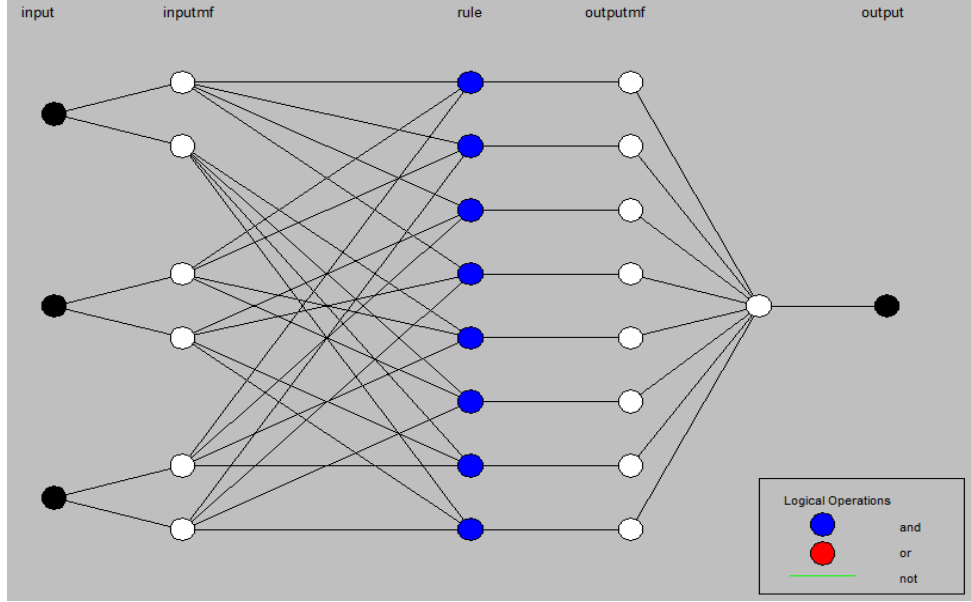
Figure 10. The structure of the selected ANFIS